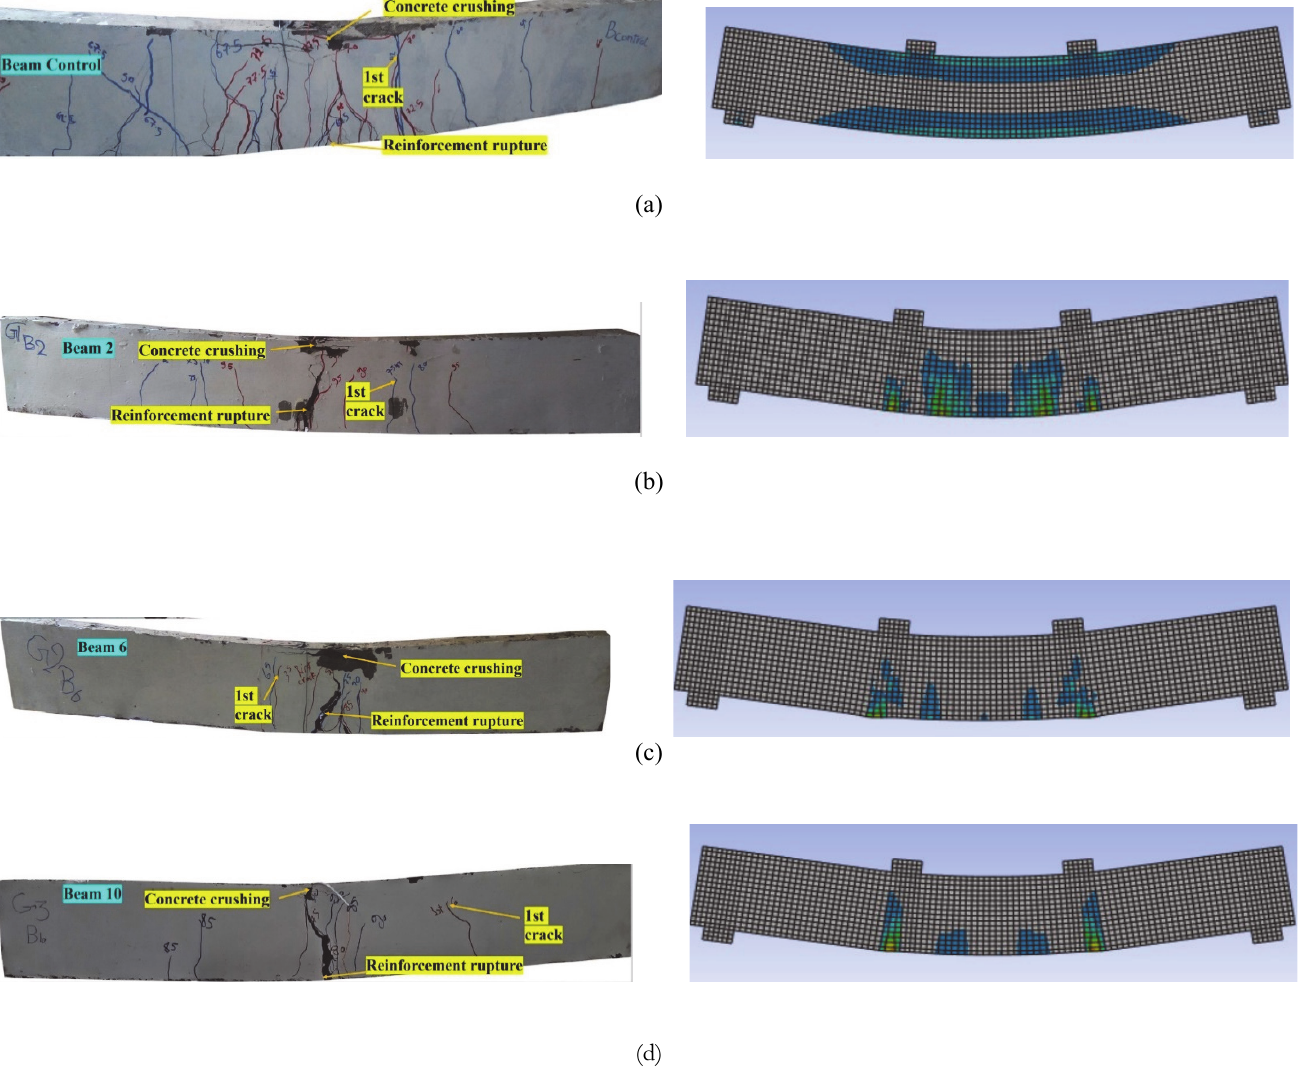
Figure 17: Experimental versus finite element the failure mode and crack pattern of tested beams: (a) control beam, (b) Group1, (c) Group2, and (d)